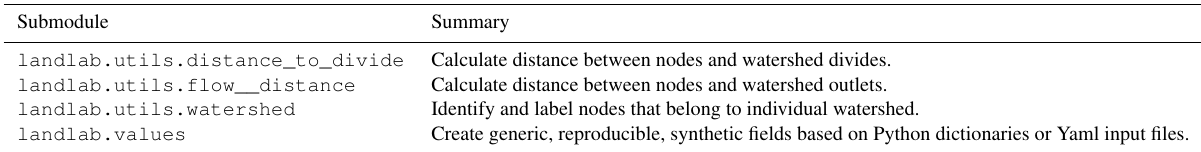
Table 2. Major new utilities in Landlab v2.0. Submodule